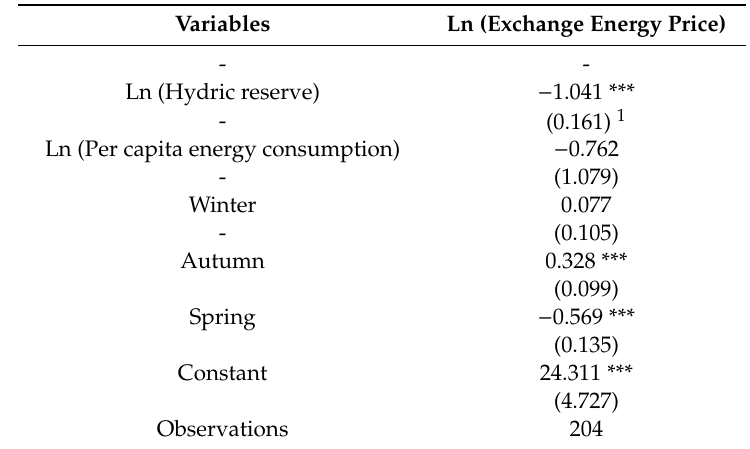
Table 4. Regression model for the Norway